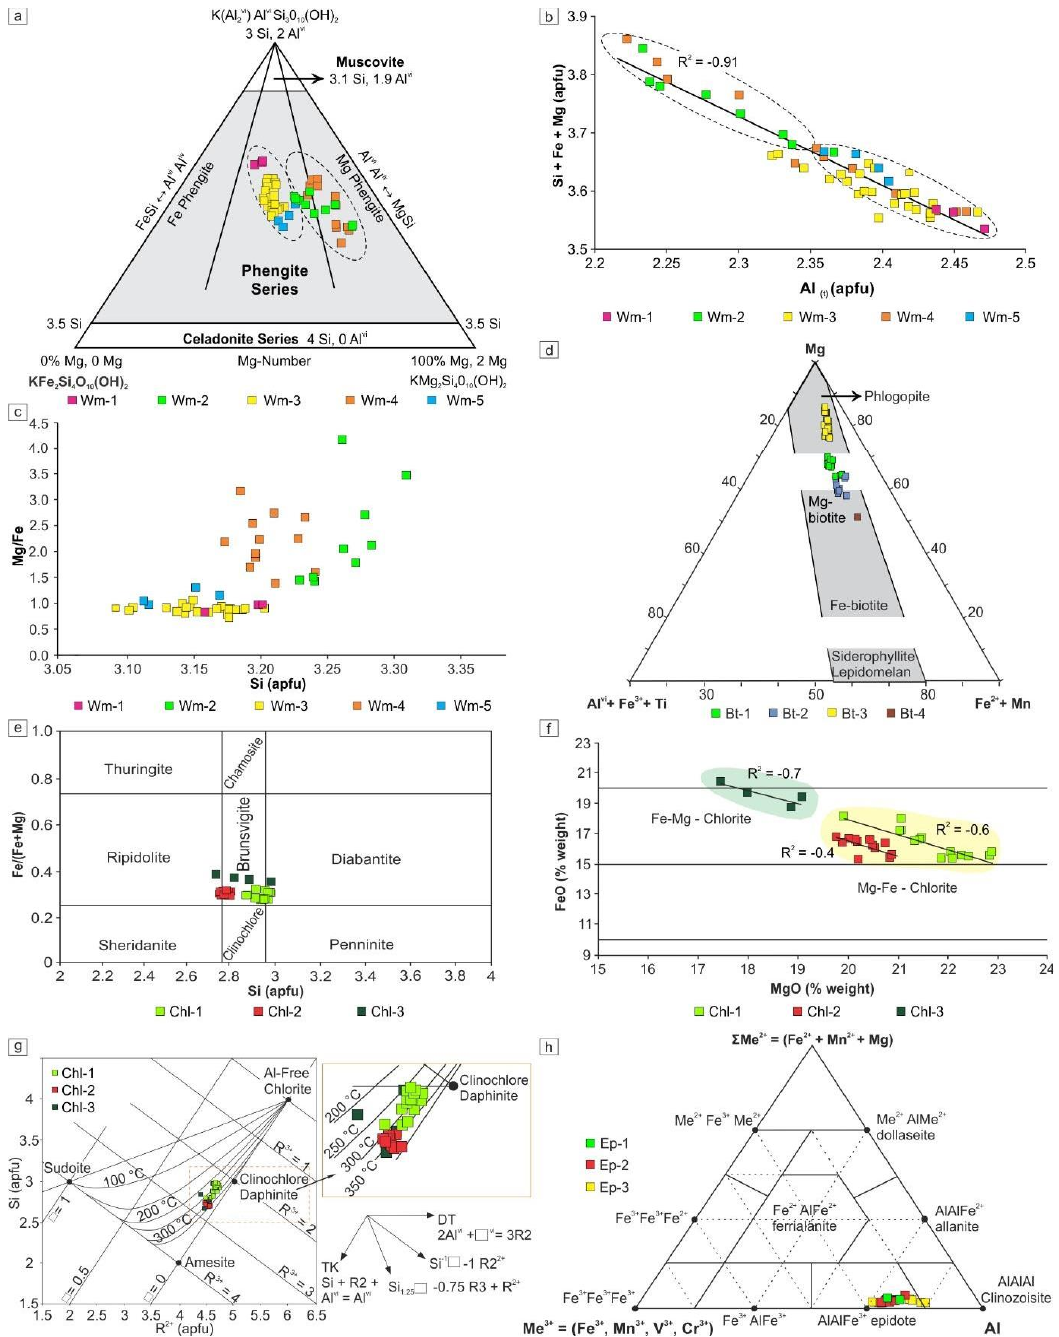
Figure 8. Mineral chemistry (EMPA) of the Paraíba deposit: white mica ( a – c ), biotite ( d ), chlorite ( e – g ), and epidote ( h ). ( a ) Compositional field of the Phengite Series [70]. ( b ) Al (t) vs (Si + Fe + Mg) correlation diagram (R 2 = correlation coefficient). ( c ) Si vs. Mg/Fe white mica distribution. ( d ) Biotite classification according to Foster [71]. ( e ) Chlorite classification Si vs Fe/ (Fe + Mg) diagram [71]. ( f ) The FeO vs MgO chlorite distribution. ( g ) Chlorite crystallization temperatures calculated using the Bourdelle and Chatelineau [72] geothermometer according to the Wiewióra and Weiss [73] diagram. ( h ) Ternary diagram proposed by Kartashov [74]. Abbreviations: Bt — biotite, Chl — chlorite, Ep — epidote, Wm — white mica, and Me — octahedral cations.